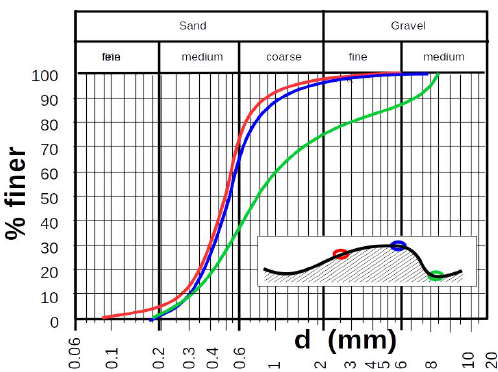
Figure 4. Varying grain size along dunes (after Vollmers and Wolf 1969